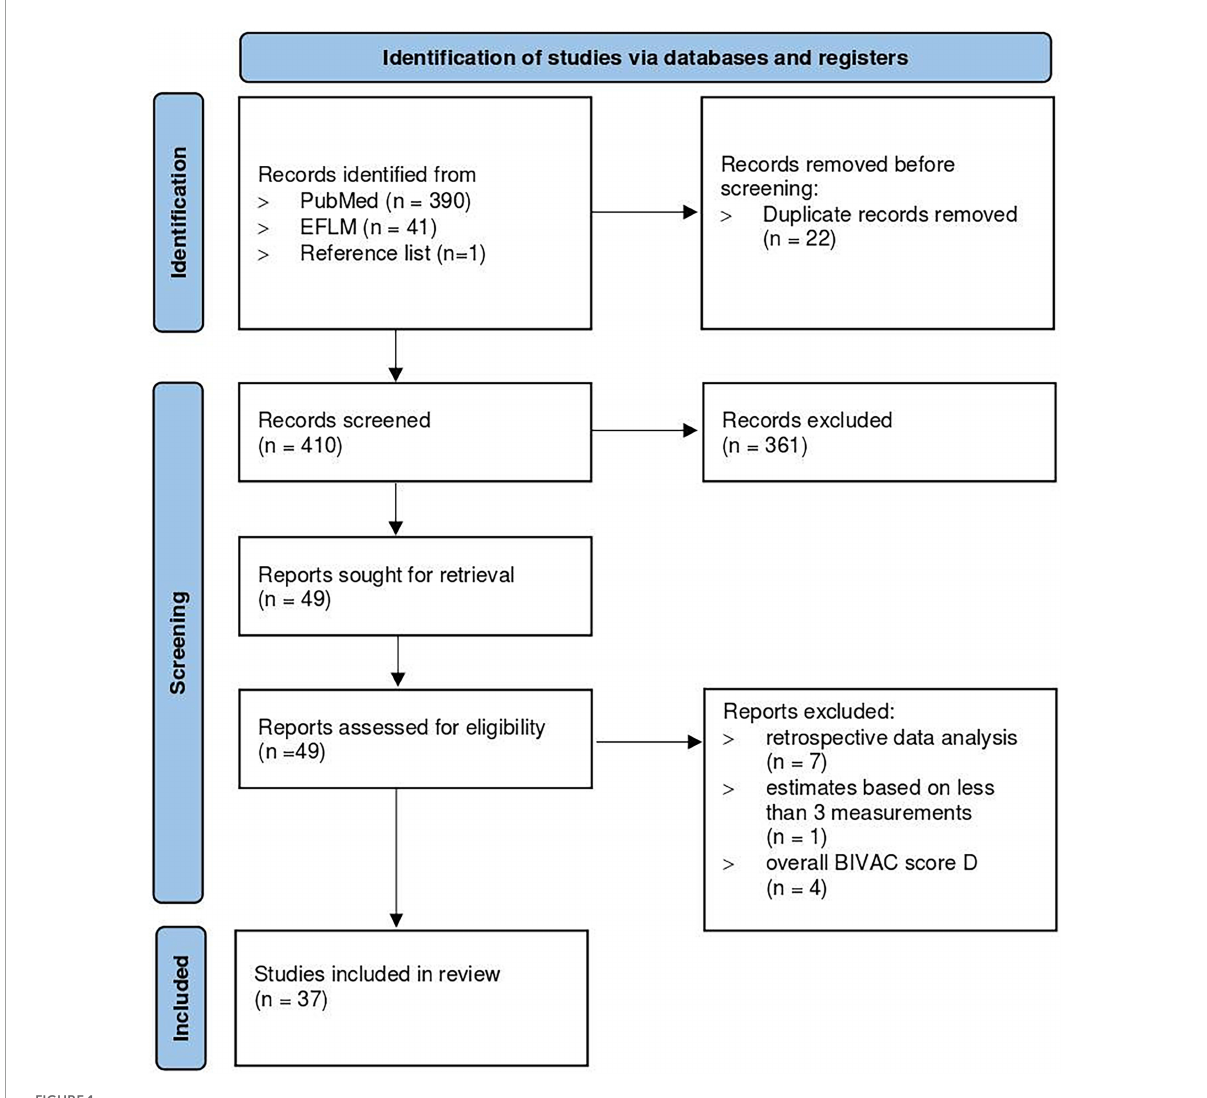
FIGURE1 Flowchart of the study selection process. The image is adapted from Page et al. (30).